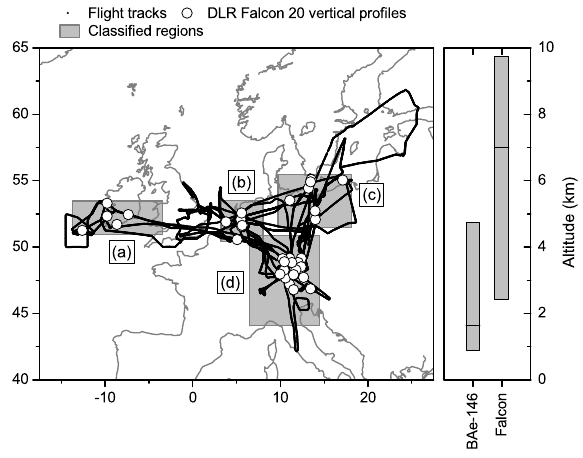
Fig. 1. Flight tracks of DLR Falcon 20 and FAAM BAe-146 during the EUCAARI-LONGREX campaign (black lines). The black cir- cles denote the position of vertical in-situ profiles measured aboard the DLR Falcon 20. The grey shades depict the regions used for the classification of vertical profiles (see Section 3.4): Ireland (a) , Benelux States (b) , North-east Germany and Baltic Sea (c) , and South Germany (d) . The box plot in the right panel shows the ver- tical extension of the measurement flights (median and 1st and 3rd